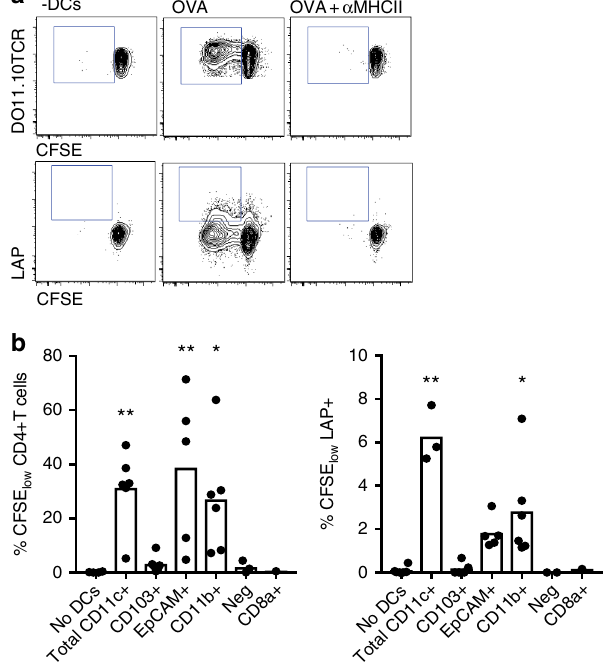
Fig. 3 Presentation of antigen by skin-draining DC subsets. a Proliferation and induction of LAP + T cells in the CFSE-low DO11.10 CD4 + T cells after co-culture with CD11c + cells isolated from brachial LN of Balb/c mice receiving topical OVA, in the presence or absence of anti-MHCII antibody. b Proliferation and percentage of LAP + T cells in the CFSE-low DO11.10 cells after co-culture with sorted DC subsets (ratio 5:1, Tcells:DCs). N = 4 – 5 replicates for populations CD103 + , EpCAM + and CD11b + , 1 – 2 replicates for populations Neg and CD8a + . * p < 0.05, ** p < 0.01 vs. No DCs. Kruskal – Wallis test with Dunn ’ s multiple comparisons. Gating for sorting